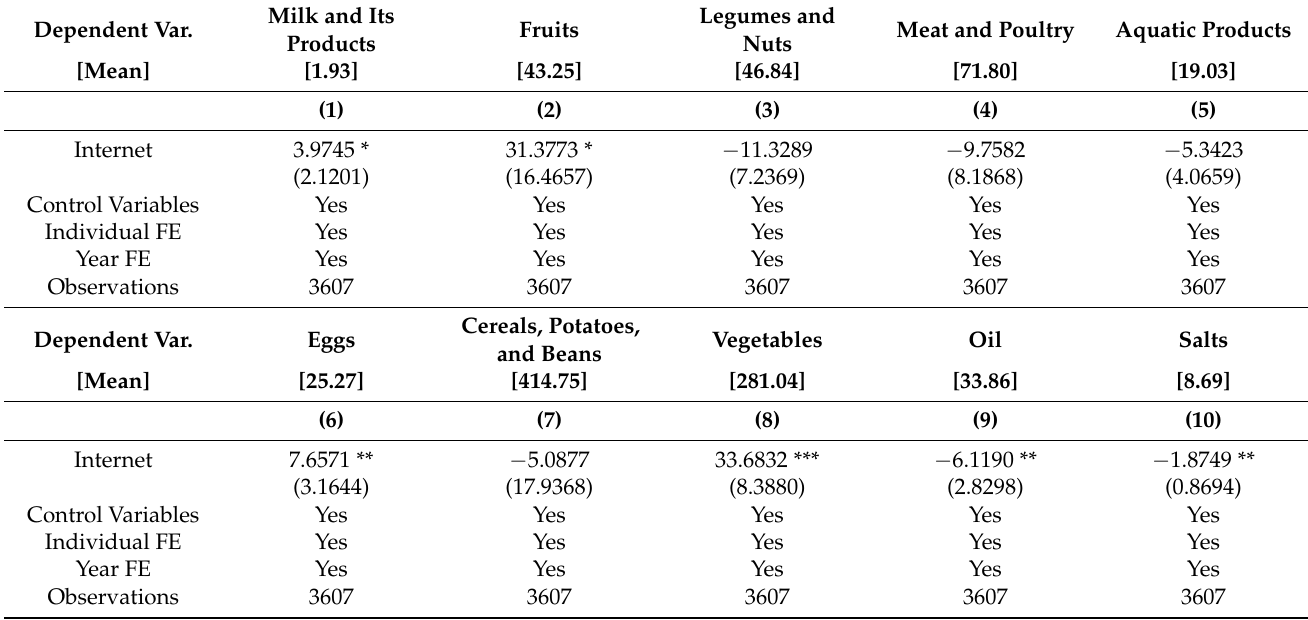
Table 4. Internet use effects on food consumption amounts of rural adults for various food